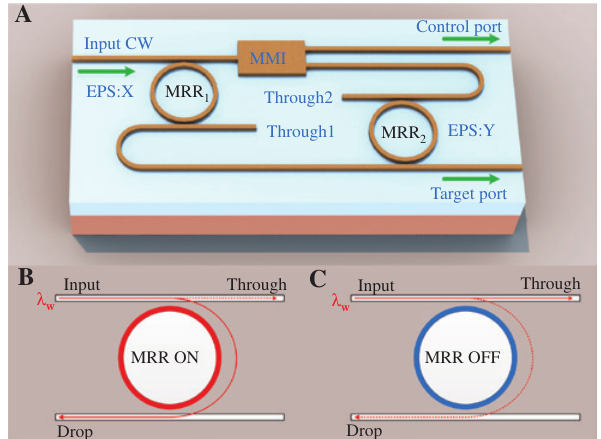
Figure 1: Schematic of the proposed device and switching element.